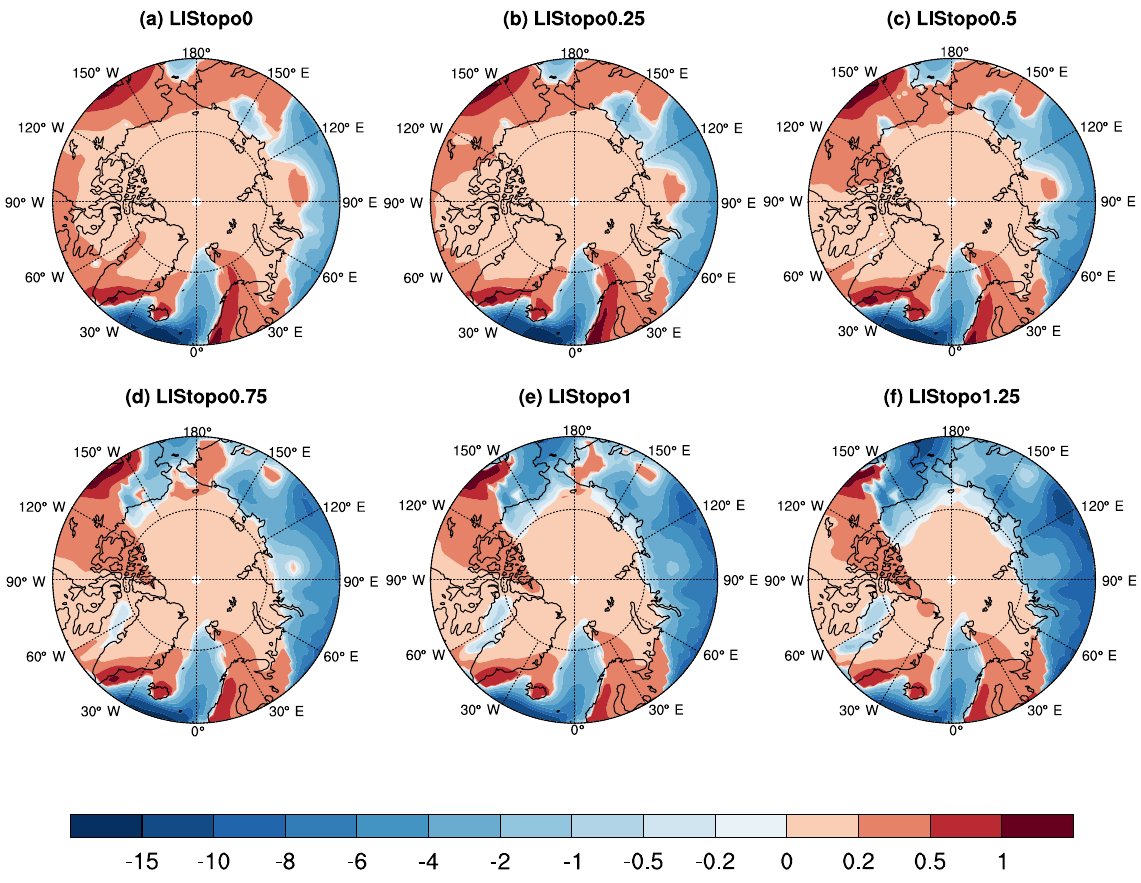
Figure 4. Estimated annual SMB (myr − 1 ) in the Arctic region from the LGM simulations.